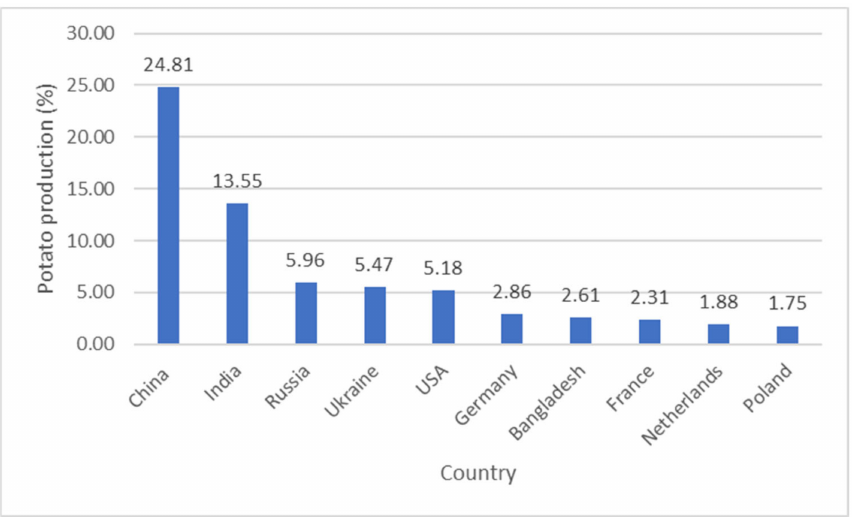
Figure 3. World’s leading potato producers in 2019